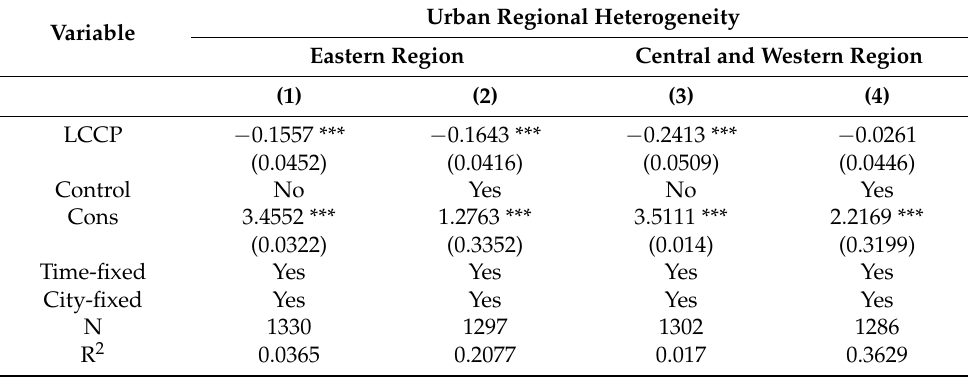
Table 8. Estimation results of analysis of urban regional heterogeneity.